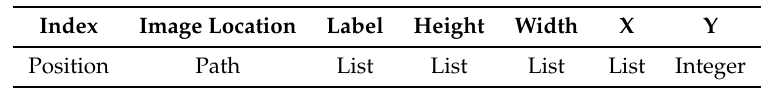
Table 1. CSV header for datasheet.